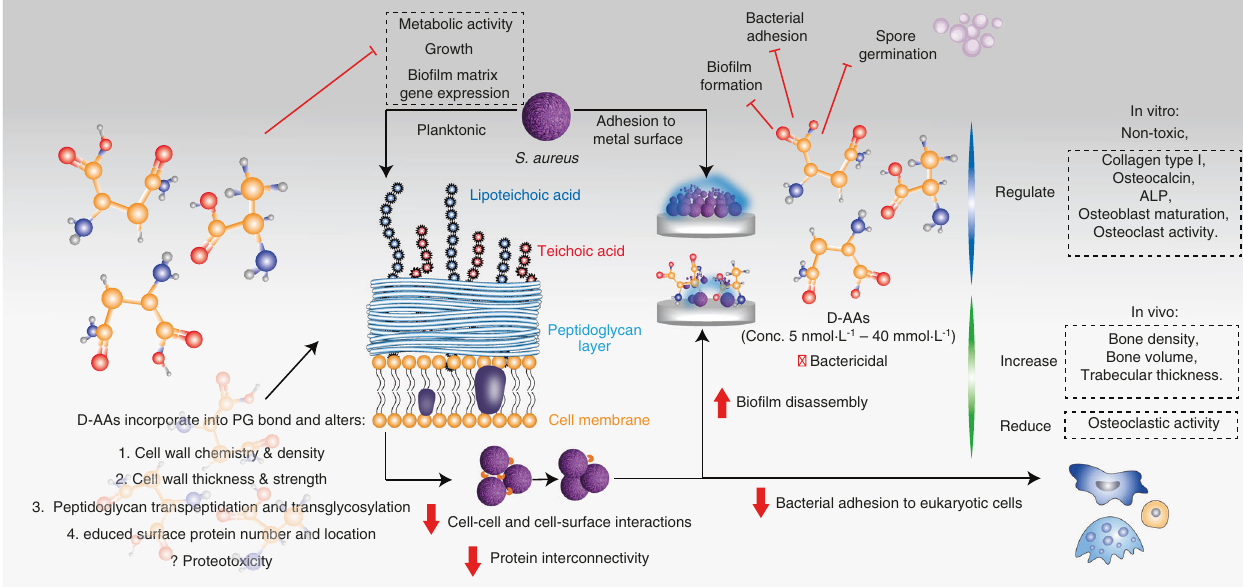
Fig. 6 A schematic showing contemporary understanding of the role of exogenously applied D-AAs in regulating the bacterial species (e.g ., S. aureus ) associated with PJI in osteocompetent cells and bone tissue. D-AAs are not bactericidal but prevent pathogenic adhesion to surfaces and host cells, spore germination, and bio fi lm formation and are able to disassemble established bio fi lms. The mechanism(s) for this remains unknown. One route in which D-AAs may prevent bacterial adhesion is by reducing the number of hydrogen bonds (H-bonds) and thus adhesive forces to the surface. Furthermore, the mechanism of D-AA incorporation into the peptidoglycan bond may alter cell wall chemistry, density, thickness, and strength, thereby disrupting surface protein numbers and locations. This in turn may disrupt cell ‒ cell and cell-surface adhesion to abiotic surfaces and to eukaryotic host cells. The impairment of surface proteins may also decrease cell interconnectivity, thereby preventing bio fi lm assembly while also promoting bio fi lm disassembly. D-AAs have been shown to be nontoxic to host cells at lower concentrations that are able to regulate pathogenic activity. In terms of bone, D-AAs directly regulate collagen type I, osteocalcin, alkaline phosphatase (ALP), osteoblasts, and osteoclast activity in vitro. In vivo studies have reported a bene fi cial response